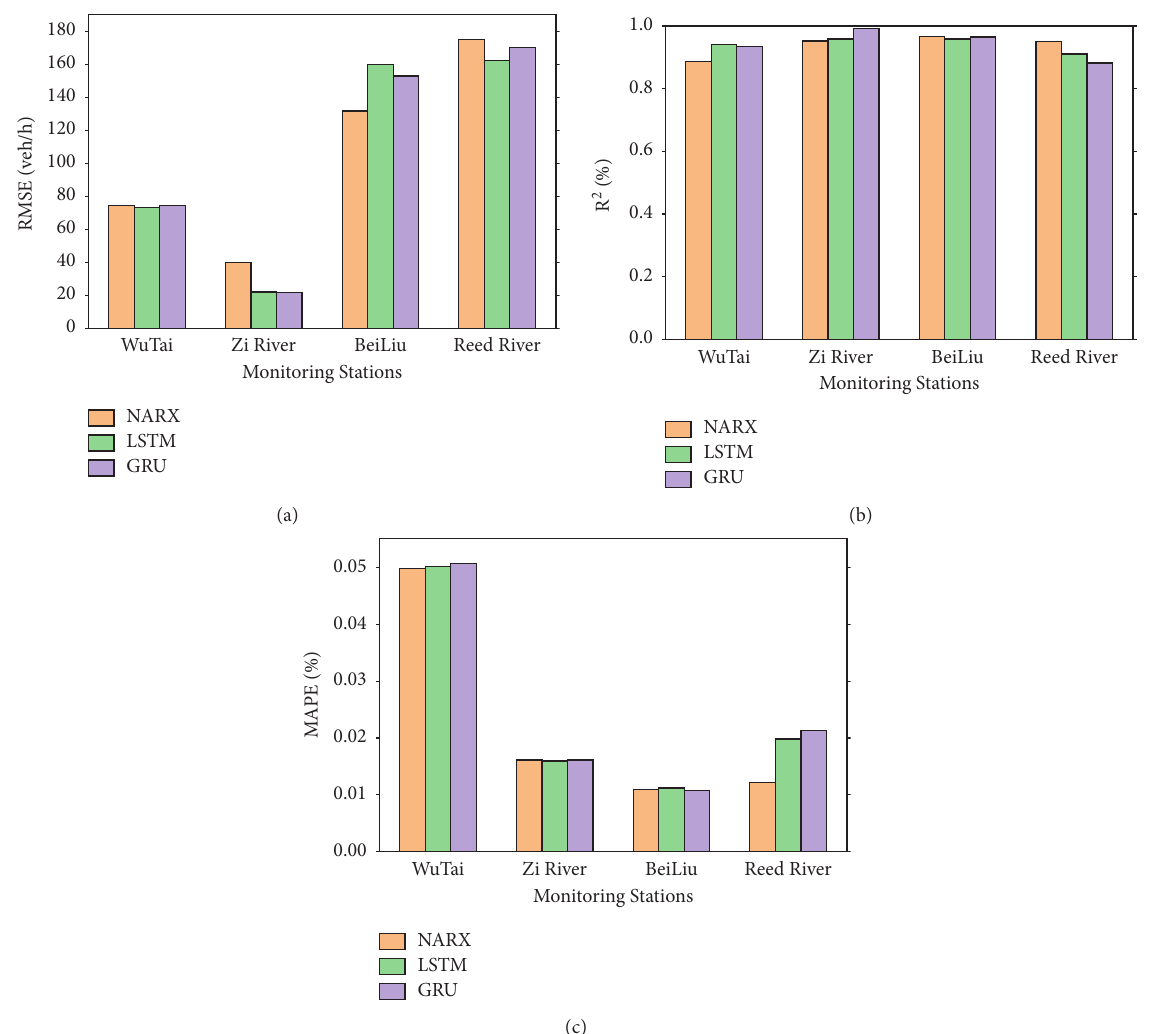
Figure 10: Comparison of evaluation indicators for predicted results at the four monitoring